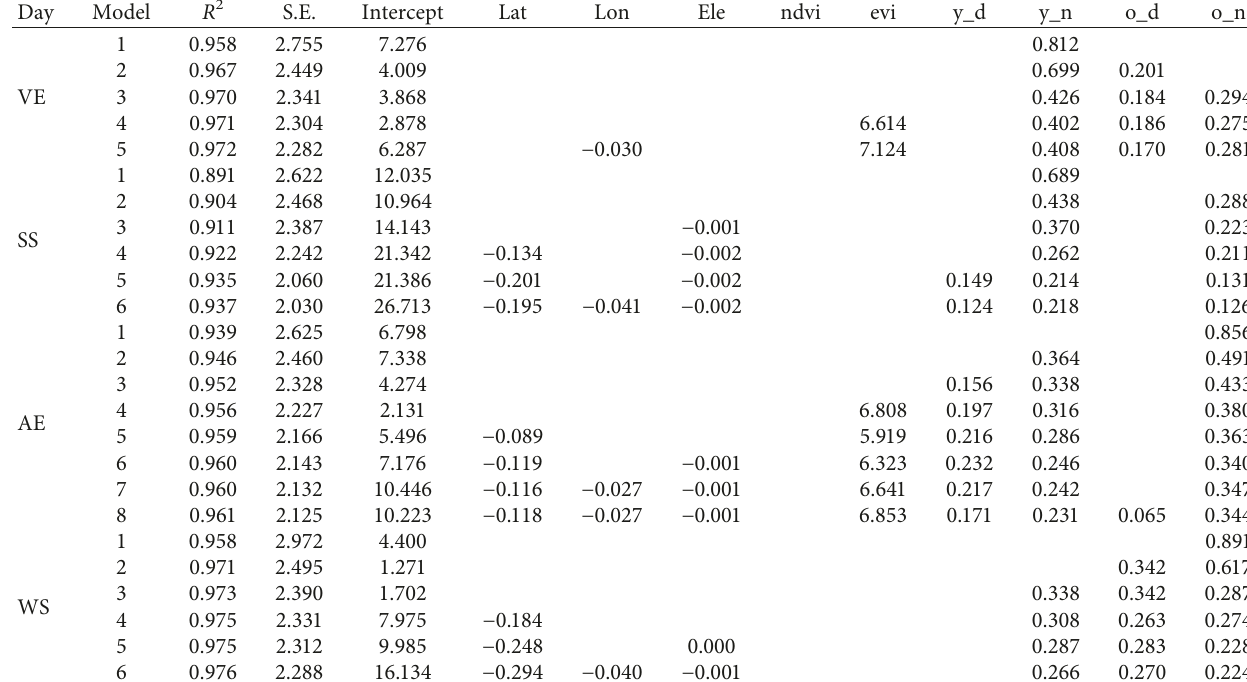
Table 2: Best models with T a -mean regressed on different sets of covariates and their specifications for the selected four days. Day Model